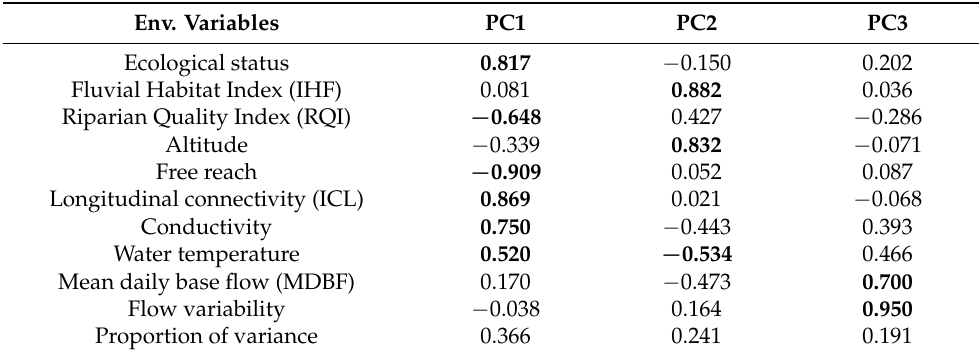
Table 2. Loadings and proportions of variance extracted by PCA of environmental variables with varimax rotation. Loadings > 0.50 are marked in bold.